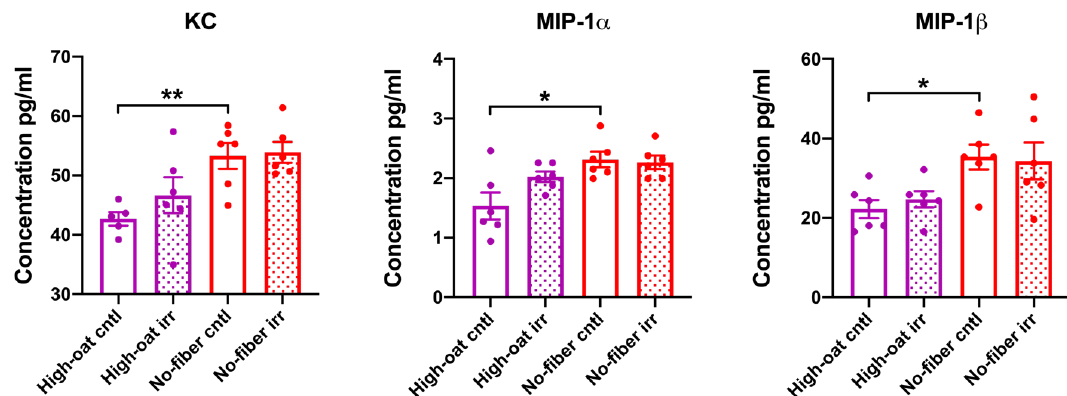
Figure 2. Serum cytokine and chemokine levels in mice at 1 week post-irradiation. A two-tailed Mann–Whitney test was used to compare the cytokine and chemokine levels in High-oat irr vs. High-oat cntl, No-fiber irr vs. No-fiber cntl, High-oat irr vs. No-fiber irr, and High-oat cntl vs. No-fiber cntl groups. Data shown are average concentrations and the error bars represent SEM. * p ≤ 0.05; and ** p ≤ 0.01.